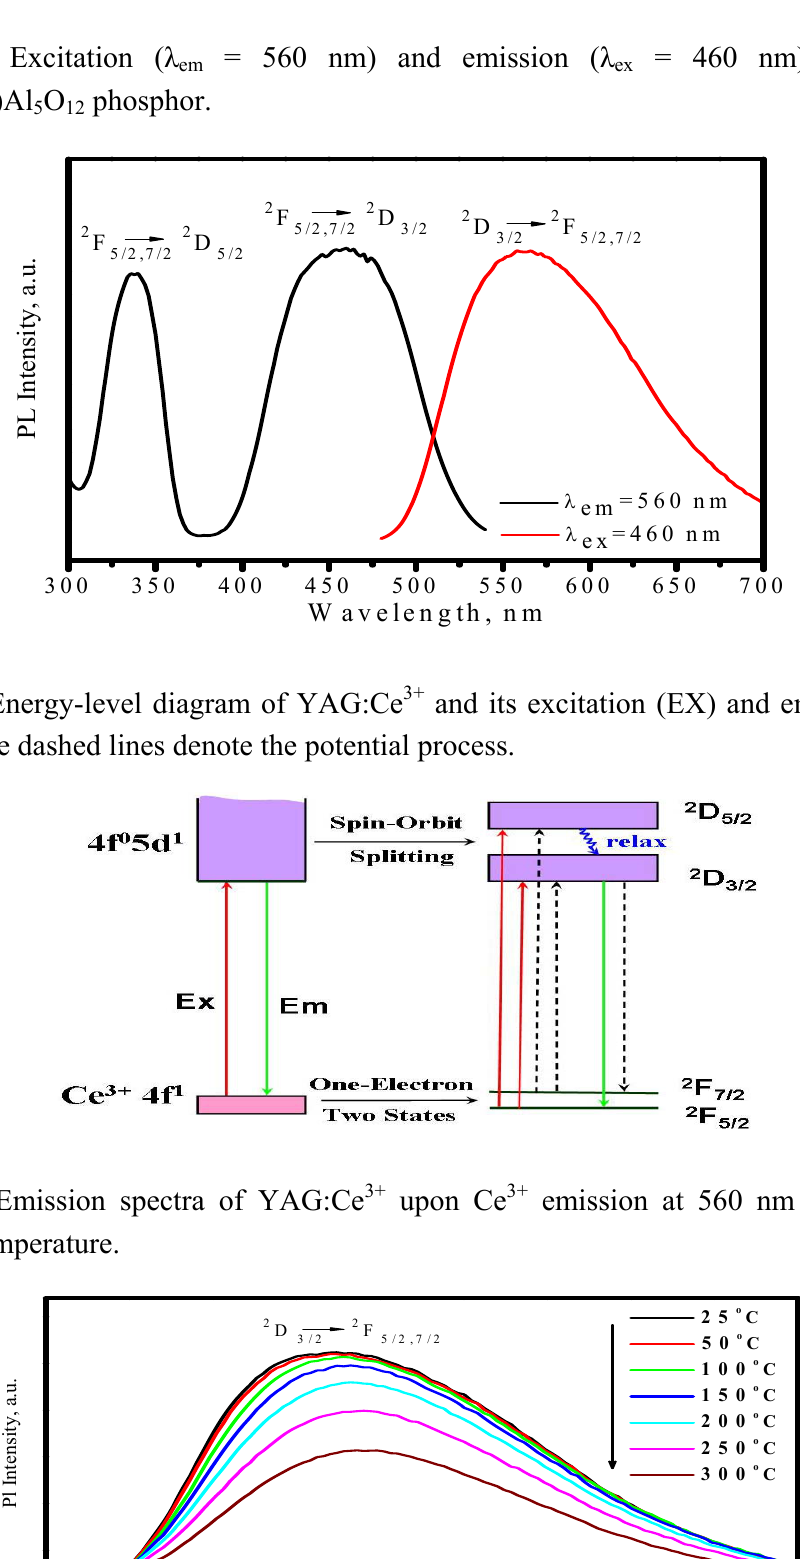
= 460 nm) spectra of ex